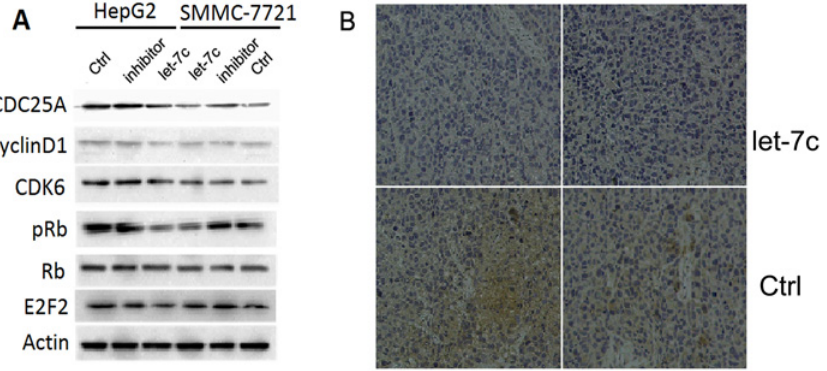
Fig 7. Effect of Let-7c on CDC25A, CDK6, CyclinD1, pRb, Rb and E2F2 protein expression in HCC cells. (A) HepG2 and SMMC-7721 cells were transfected with the let-7c agomir, let-7c inhibitor or negative control. Levels of CDC25A, CDK6, CyclinD1, pRb, Rb and E2F2 protein were detected by western blot. The value under each band indicates the relative expression levels of CDC25A, CDK6, CyclinD1, pRb, Rb